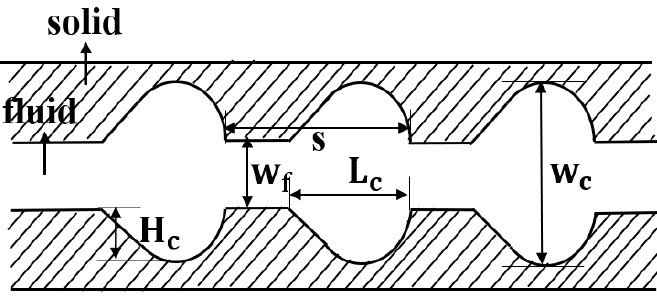
Figure 12. New shape of cavities proposed in this paper.